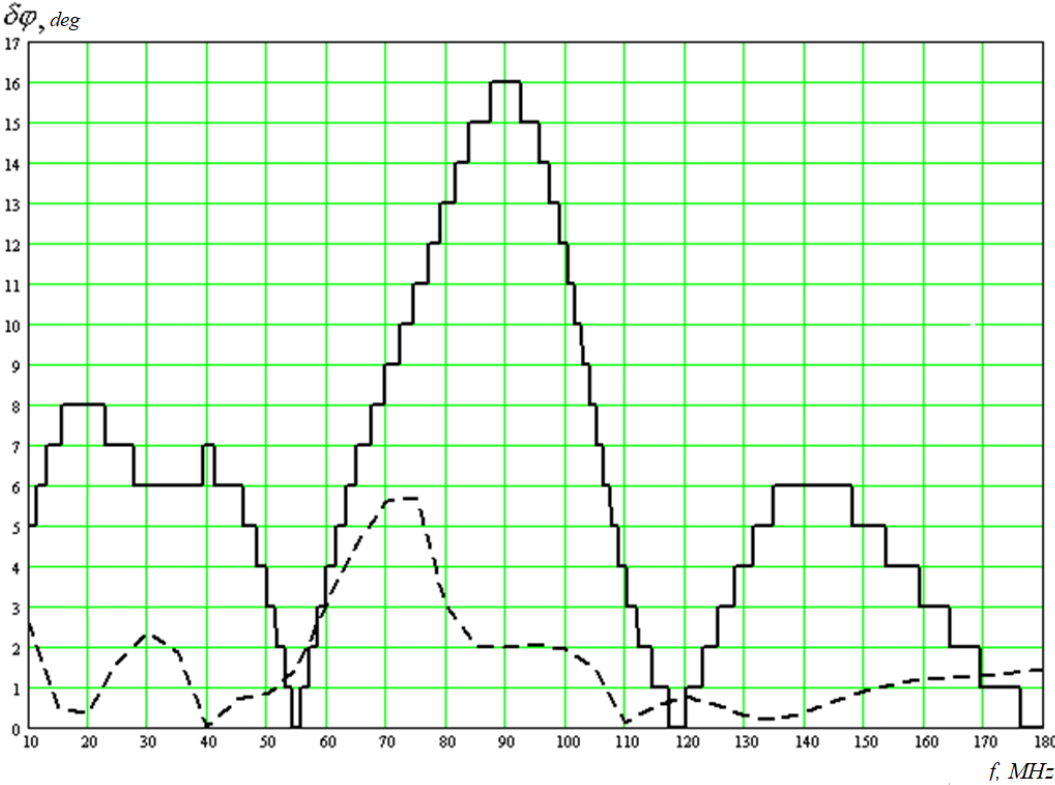
Figure 8. Frequency dependences of DOA errors ( φ incidence = 45 ◦ ): the “stepped” line represents the DOA estimated by antenna array of radius R = 0.5 m; the dashed line represents the residual error of DOA estimated by method of auxiliary sources.